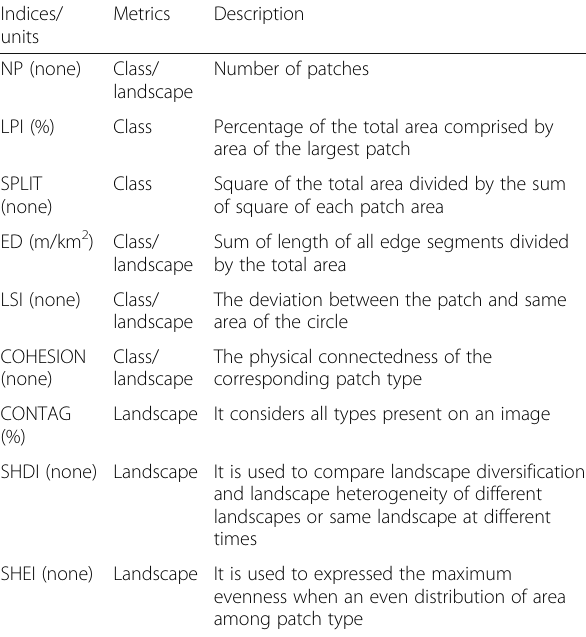
Table 1 Landscape metrics